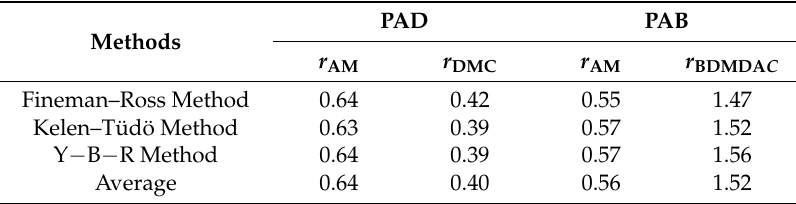
Table 3. Monomer reactivity ratios of the polymers.